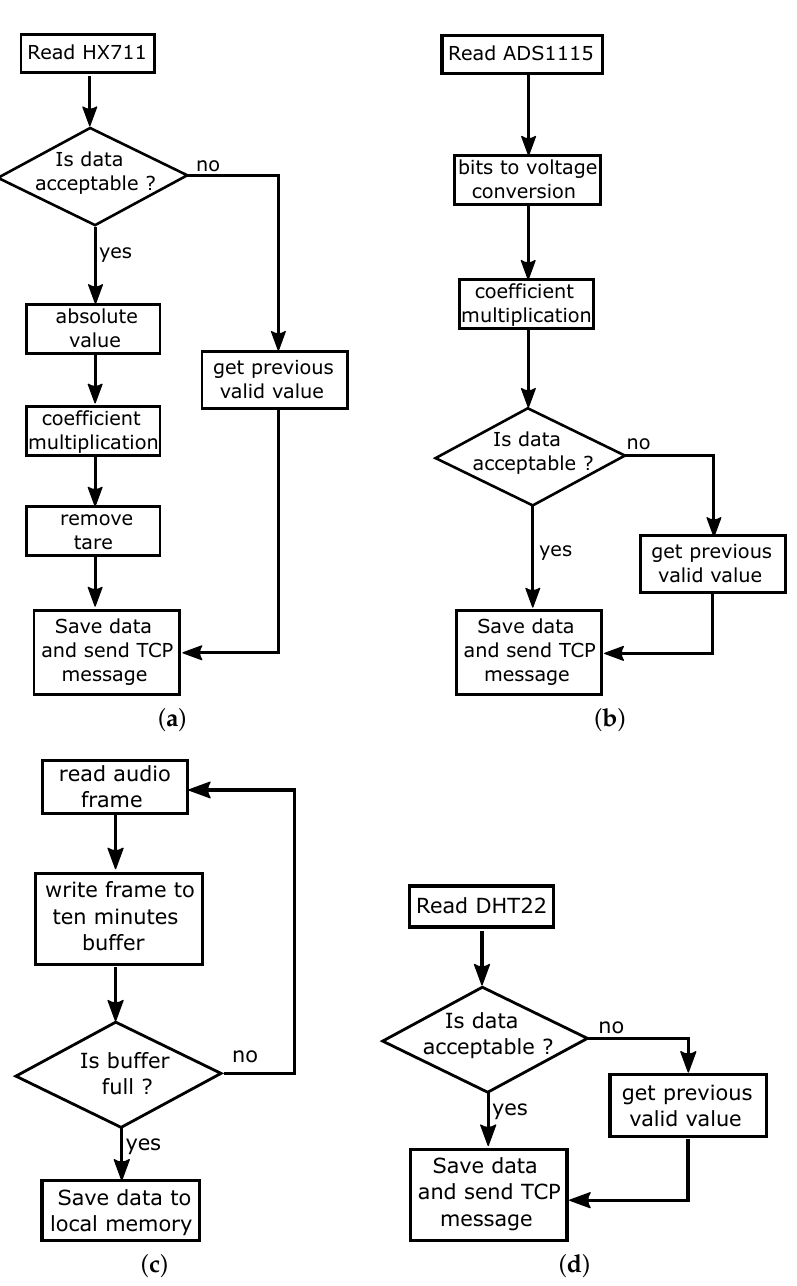
Figure 4. Flow charts of data acquisition routines, considering ( a ) weight acquisition code, ( b ) CO 2 acquisition code, ( c ) temperature and humidity code, and ( d ) sound acquisition